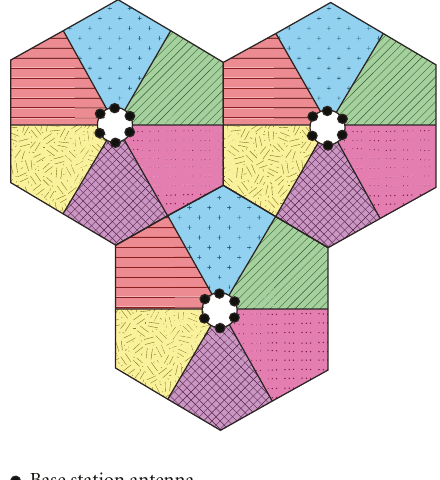
Figure 1: System model with 3 cells, each with 6 sectors. The analysis makes no assumption on the number of cells, and the frequency reuse pattern varies for the di ff erent architectures under consideration. This paper focuses on the triangular region in the center of the